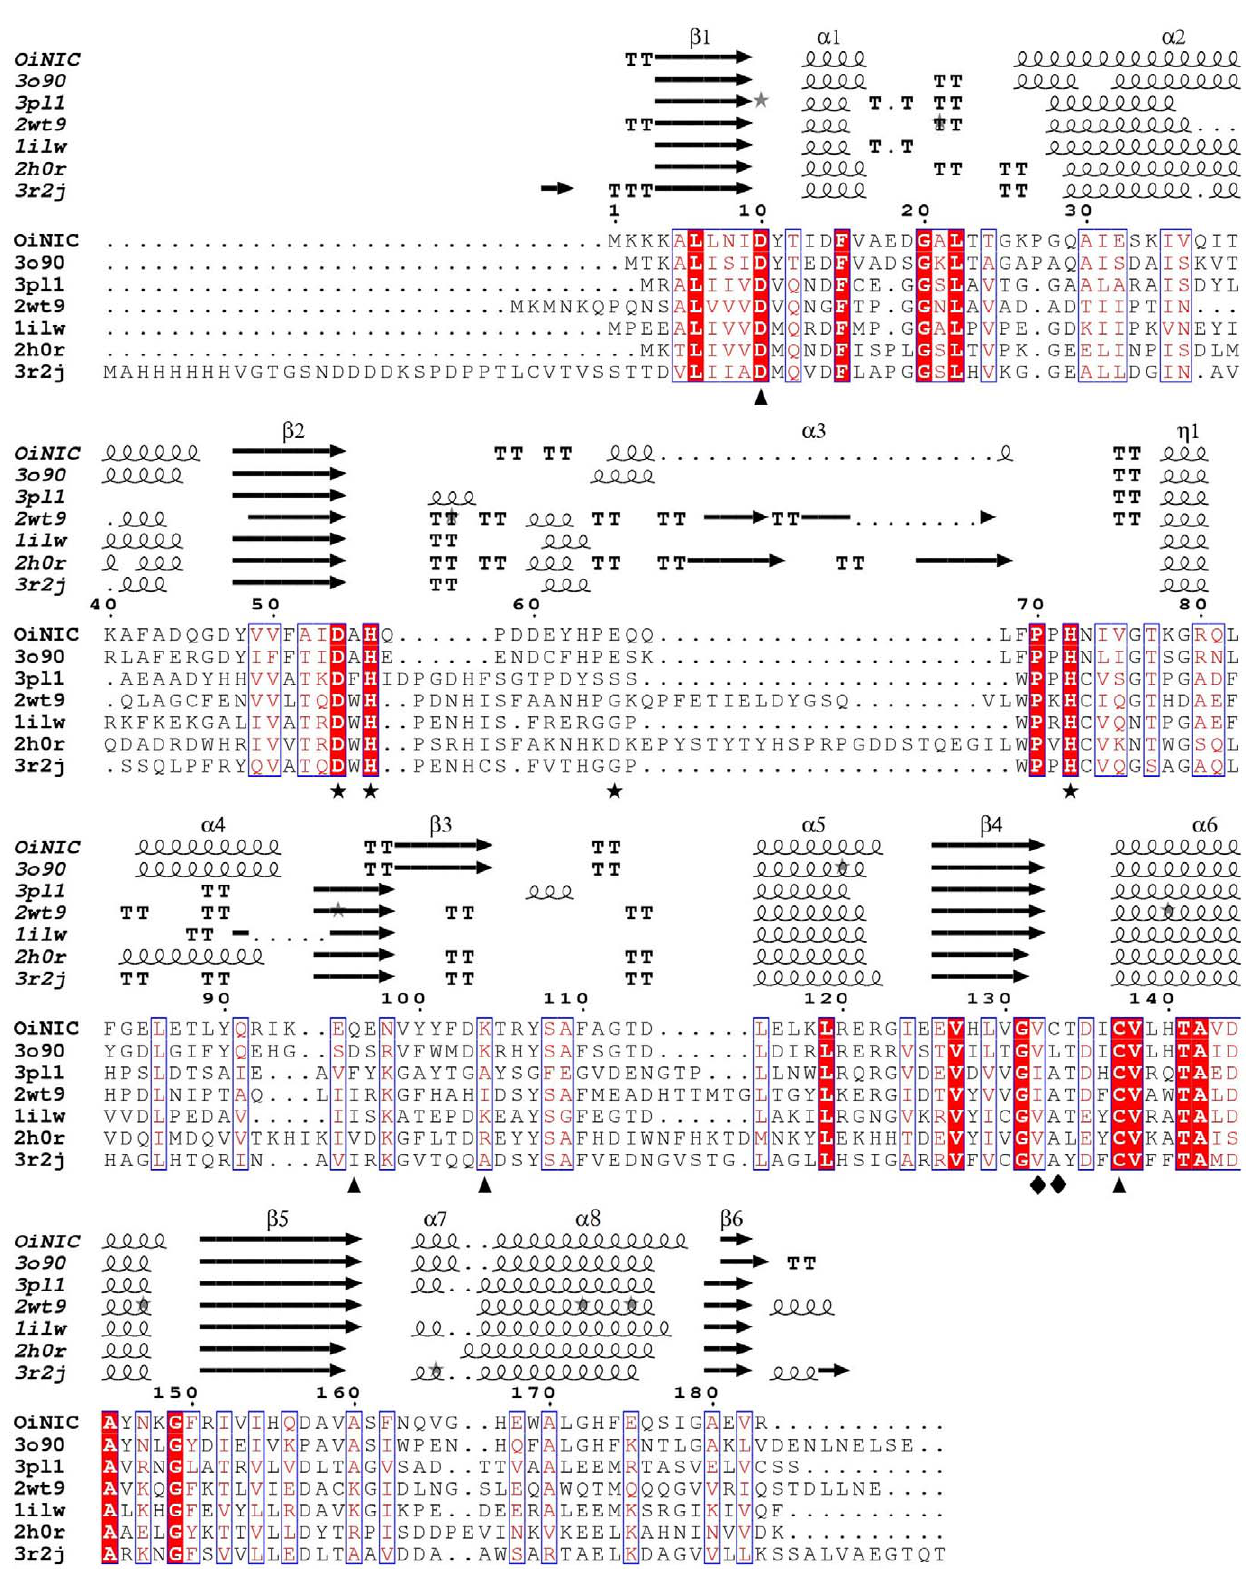
Figure 1. Multiple sequence alignment for O.iheyensis nicotinamidase (OiNIC) and related nicotinamidases. ESPript outputs [48] obtained with the crystallized nicotinamidase sequences retrieved from Uniprot database and later aligned with CLUSTAL-W [47]. Sequences are grouped according to similarity. PDB codes were 3O90 for S. pneumoniae nicotinamidase (SpNIC), 1ILW for P. horikoshii nicotinamidase (PhPncA), 3PL1 for M. tuberculosis nicotinamidase (MtPncA), 2WT9 for A. baumanii nicotinamidase (AbPncA), 2H0R for S. cerevisiae nicotinamidase and 2R3J for